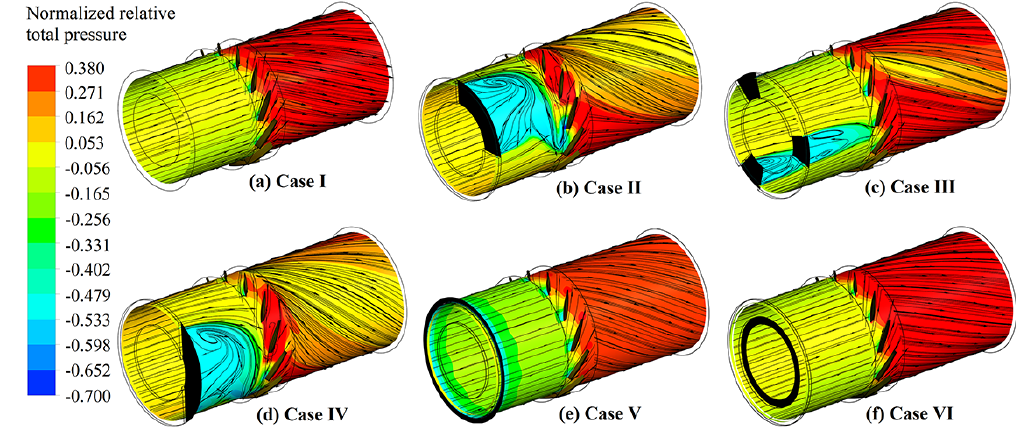
Figure 9. Normalized relative total pressure contours and streamlines on 80% span circumferential plane at design